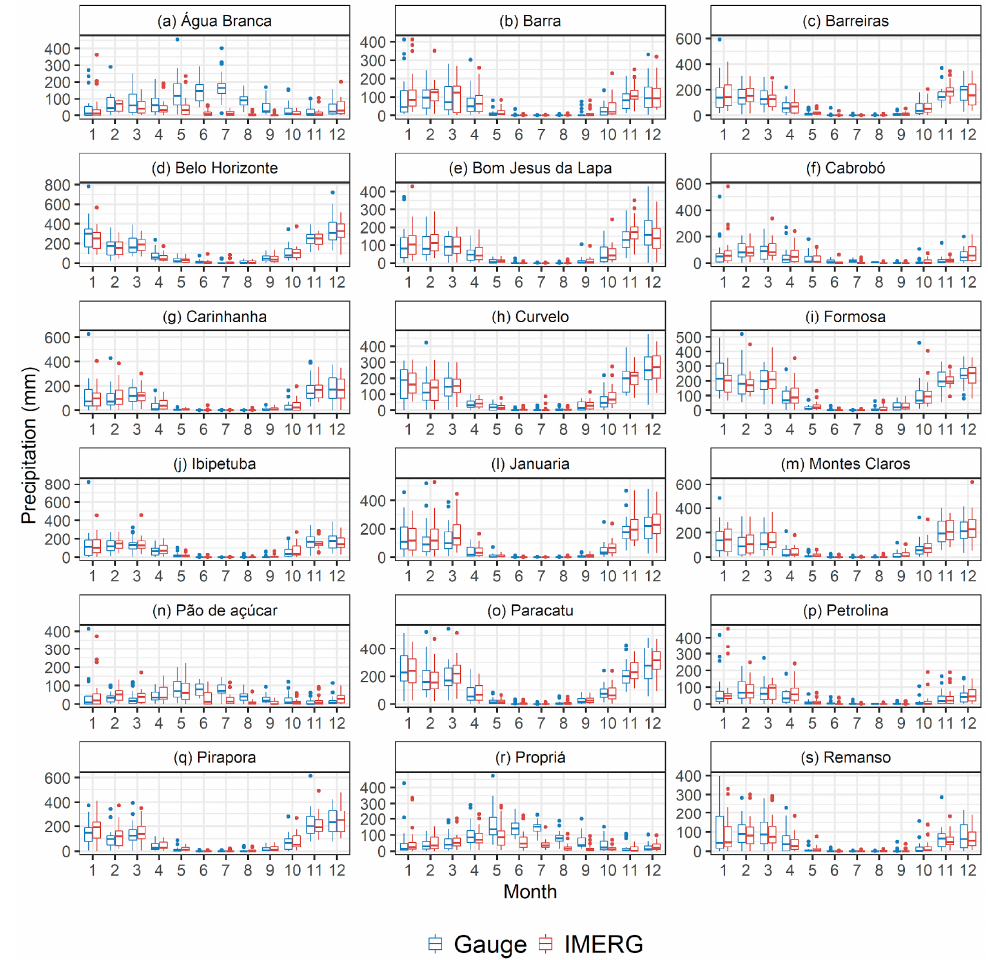
Figure 4. Boxplot of monthly precipitation during 2000 to 2019 at each gauge ( a ) Água Branca, ( b ) Barra, ( c ) Barreiras, ( d ) Belo Horizonte, ( e ) Bom Jesus da Lapa, ( f ) Cabrobó, ( g ) Carinhanha, ( h ) Curvelo, ( i ) Formosa, ( j ) Ibipetuba, ( l ) Januaria, ( m ) Montes Claros, ( n ) Pão de açúcar, ( o ) Paracatu, ( p ) Petrolina, ( q ) Pirapora, ( r ) Propriá, ( s ) Remanso.